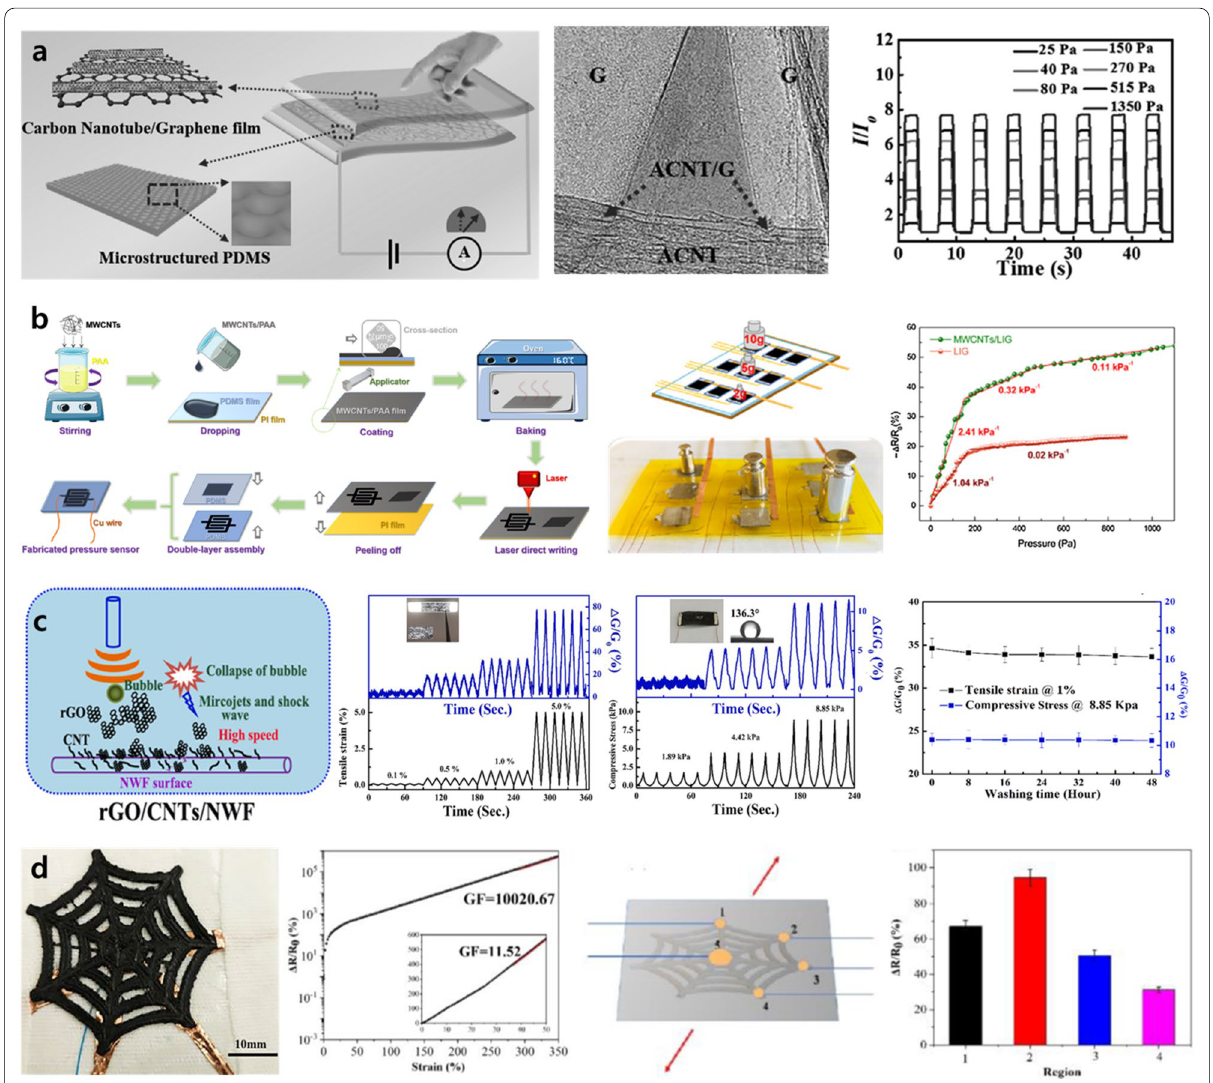
Fig. 3 Various flexible physical sensors (pressure sensor and strain sensor) based on CNT-graphene hybrids. a , b Pressure sensors using combined CNT-graphene: a Aligned CNT with graphene. Reproduced with permission [59]. Copyright 2017, John Wiley and Sons. b multi-walled CNT (MWCNT)-graphene fabricated laser direct writing (Reproduced with permission [27]. Copyright 2021, Elsevier B.V. c , d Strain sensors using CNT-graphene networks: c E-textile based on CNT-reduced graphene oxide (rGO) hybrids incorporated in non-woven fabric. Reproduced with permission [60]. Copyright 2021, Elsevier B.V. d Spyder web-like conductive polymer composites containing MWCNT-graphene nanoplatelets. Reproduced with permission [61]. Copyright 2021, Elsevier